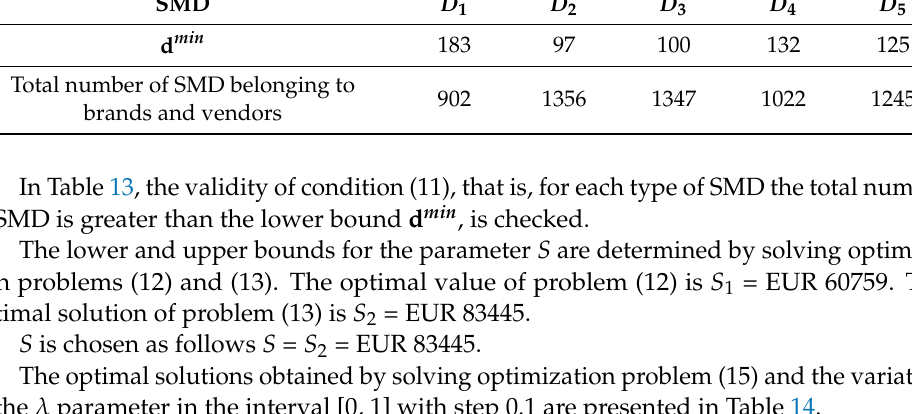
Table 13. The validity of condition (11). SMD D 1 D 2